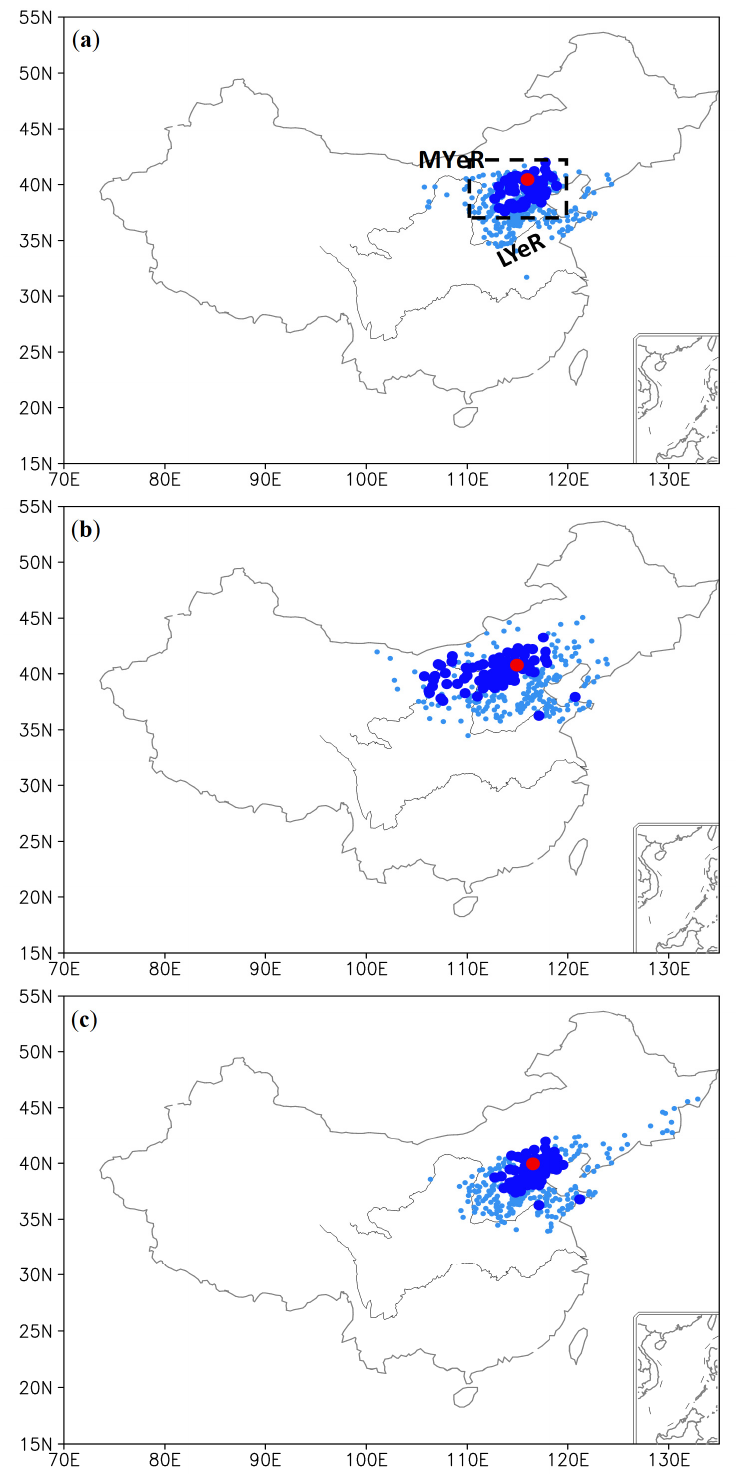
Figure 2. Spatial distribution of the ECS frequency (unit: times) at each station on all ECS occurring days at each competition zone during winter in 1981–2019 for ( a ) Yanqing, ( b ) Zhangjiakou, ( c ) Chaoyang). The small light blue dots represent frequencies of 20–29 times and the big dark blue dots represent frequencies above 30 times. The red dots in ( a – c ) denote the positions of the three stations. ( a ) Middle reaches of the yellow river (“MYeR”) and lower reaches of the Yellow River (“LYeR”). The dashed box in ( a ) means the domain representing the three competition zones.